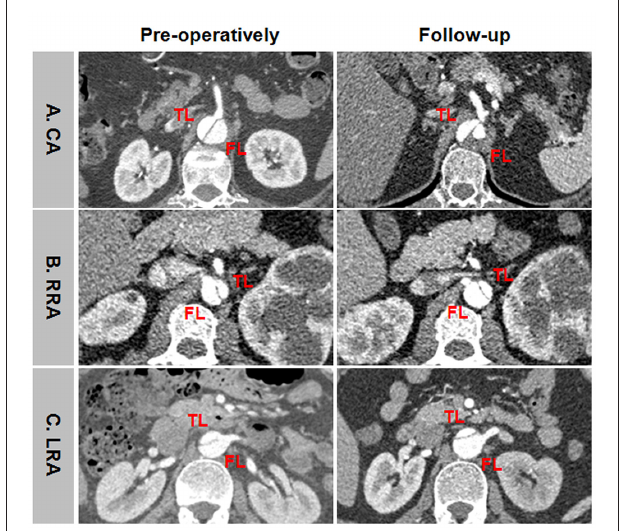
FIGURE 9 | An example of negative branch remodeling after TEVAR. (A) CA was supplied by TL at baseline and by BL during follow-up. (B) RRA was perfused by BL at baseline and by FL during follow-up. (C) LRA was supported by BL at baseline and by FL during follow-up. TEVAR, thoracic endovascular aortic repair; FL, false lumen; TL, true lumen; BL, bilateral lumen; CA, celiac artery; RRA, right renal artery; LRA, left renal